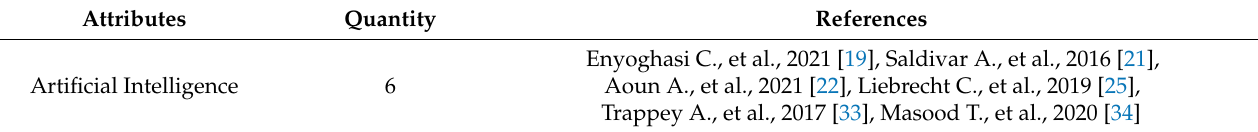
Table 1. Quantity of individual attributes of Industry 4.0 marked as important in scientific